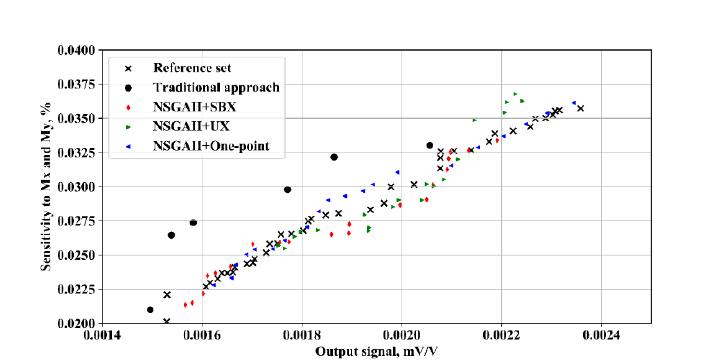
Fig. 1 2 . Results obtained from NSGA II with different settings and from the traditional